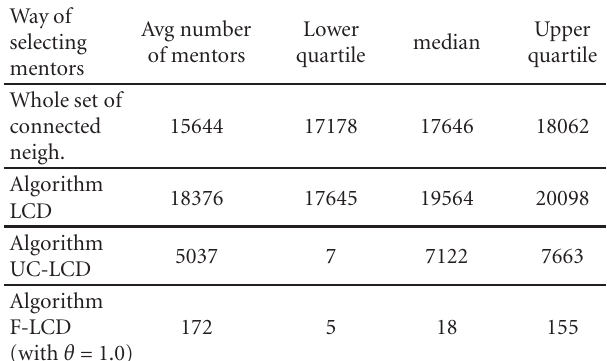
Figure 4: Precision values on MovieLens dataset for classical approaches for neighbors selection when ratings are not available.